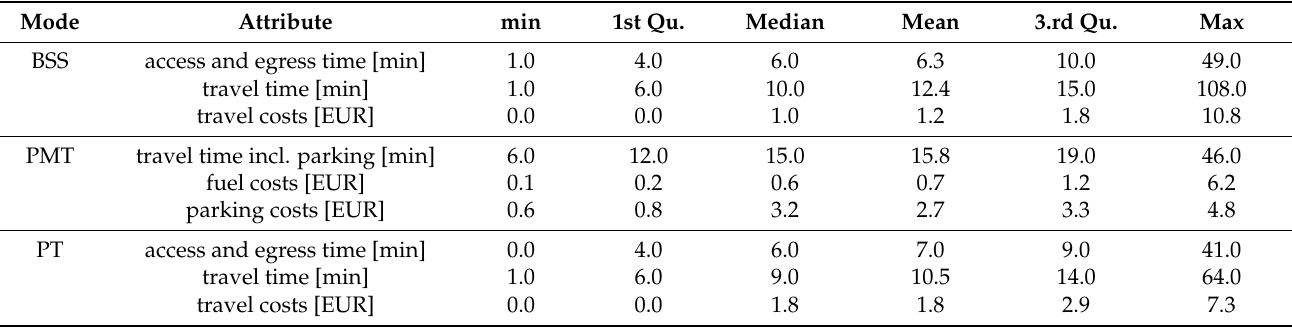
Table 4. Empirical distribution of covariates in a choice